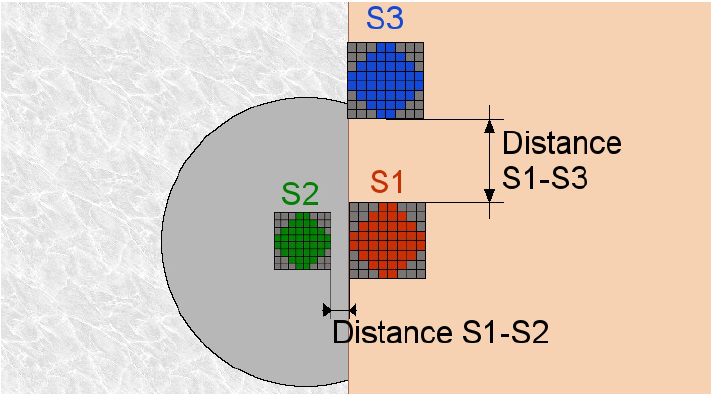
Figure 19. Dome camera perspective of the